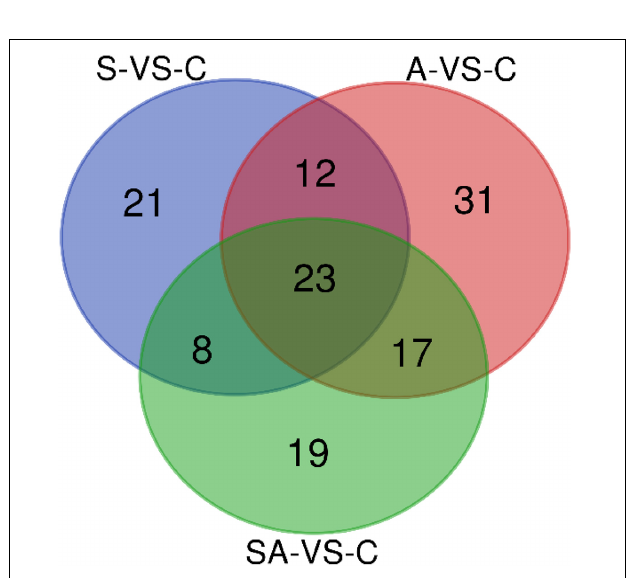
FIGURE 3 | Venn diagram of differentially expressed miRNAs between the different groups.